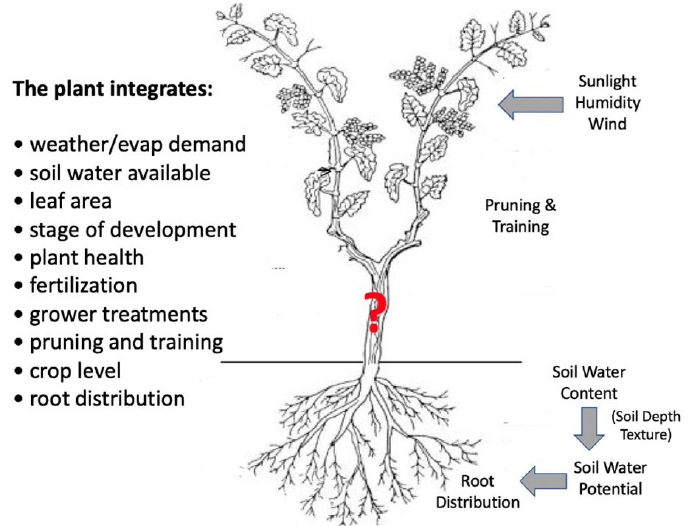
Figure 1. Representation of the many factors that affect the water status of a fruit tree or vine. Determining the plant water status directly (the red ?) is preferable to the many correlations of indirect factors. Figure modified from similar figure in Lakso and Intrigliolo